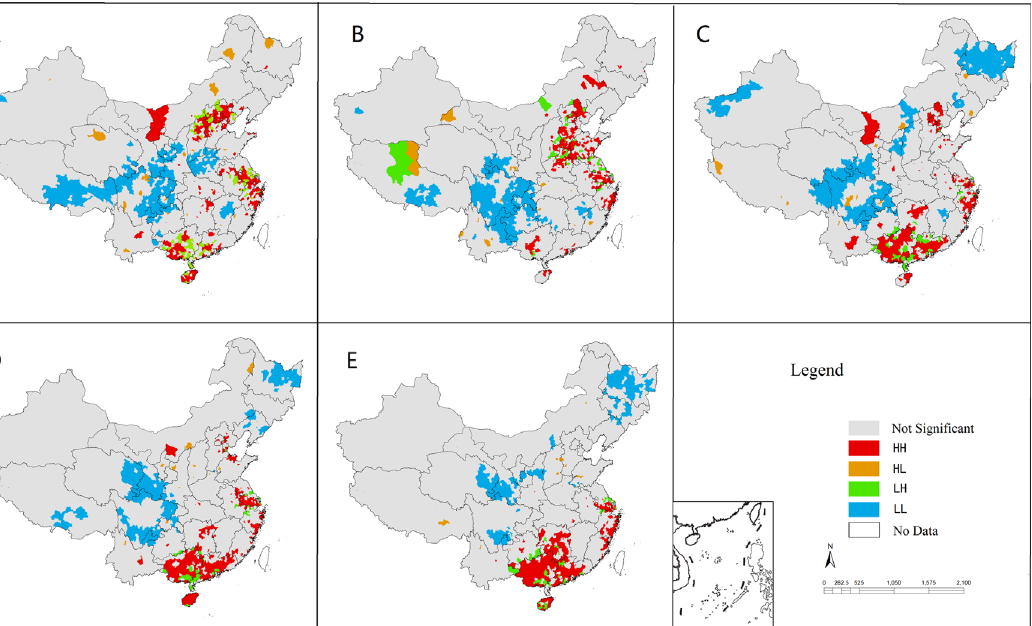
Fig 4. Spatial correlation cluster maps for HFMD incidence, 2008 – 2012 (A-E). HH, high-high cluster; HL, high-low cluster; LH, low-high cluster; LL, low- low cluster.